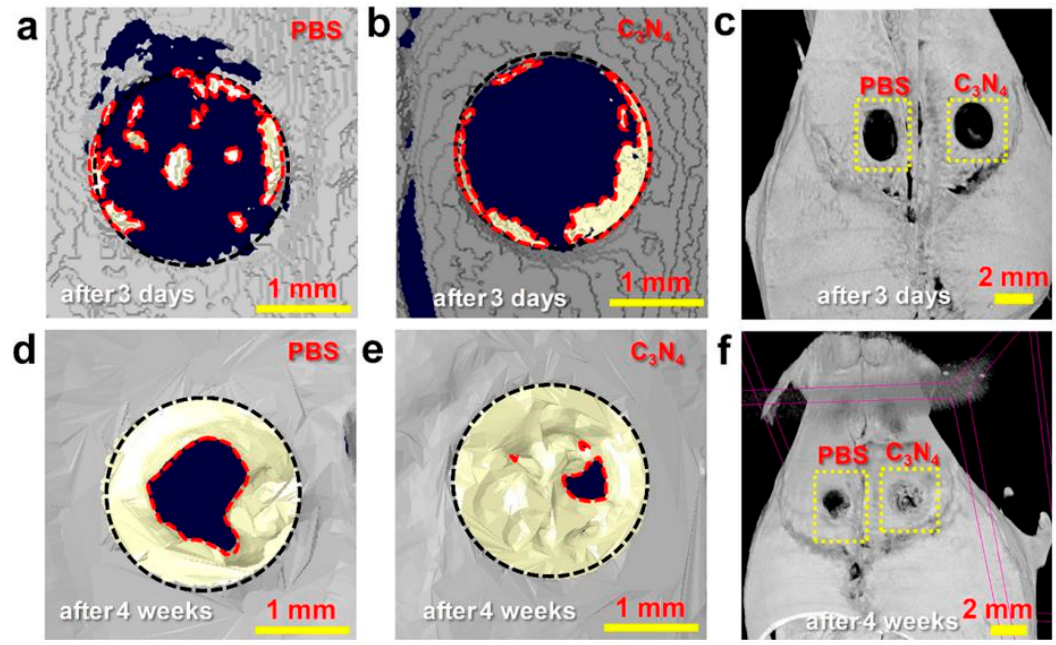
Figure 7. ( a – f ) Three-dimensional μ -CT images after 3 days or 4 weeks of PBS and C 3 N 4 nanosheet- assisted treatment for the enhanced repair of cranial bone defect under red light in vivo [88]. C 3 N 4 sheets showed the potential for promoting bone formation. Reproduced from [88] with permission from American Chemical Society,